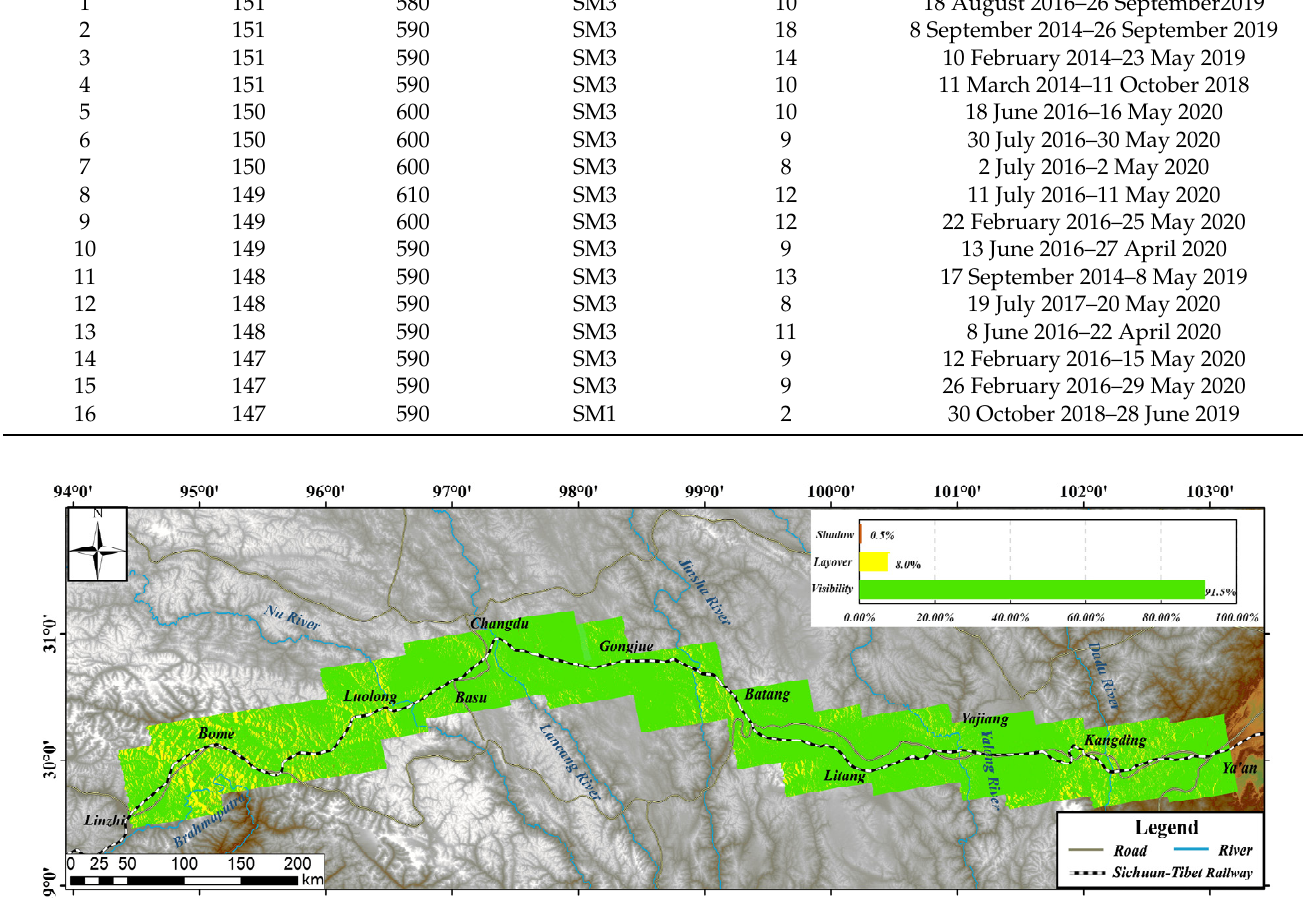
Table 1. Parameters of synthetic aperture radar (SAR) satellite images.